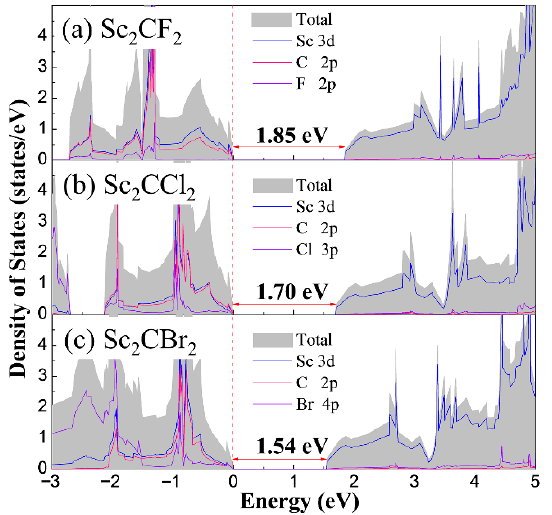
Figure 4. The total and partial density of states of ( a ) Sc 2 CF 2 , ( b ) Sc 2 CCl 2 , and ( c ) Sc 2 CBr 2 . The Fermi energy is marked by dashed lines.